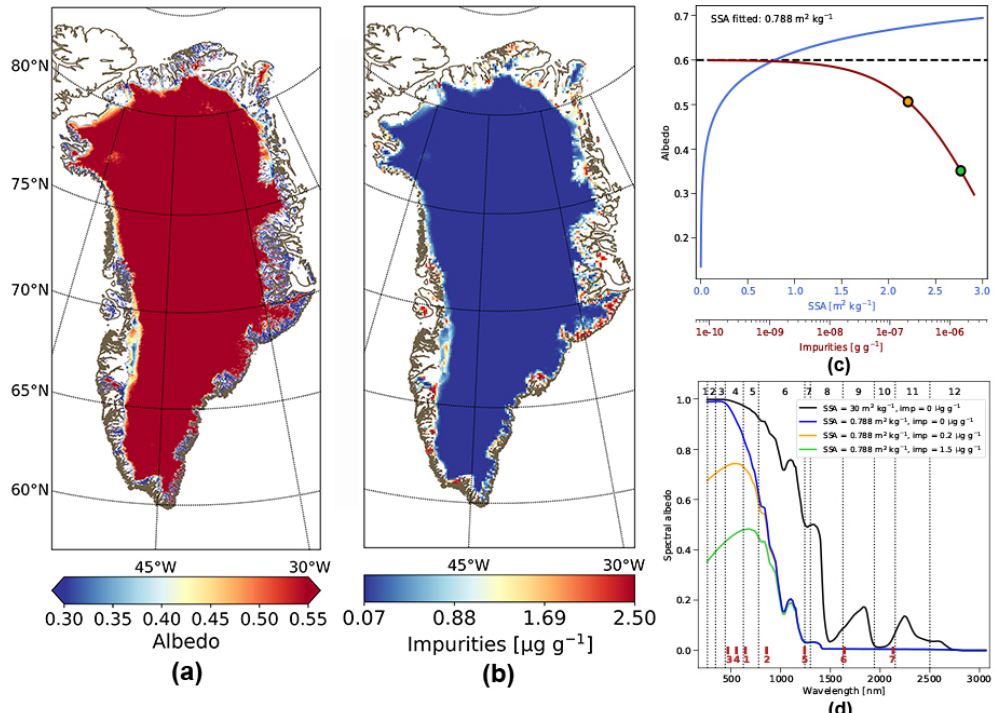
Figure 1. (a) Lowest 5% of the MODIS MCD43A3v5 1km 16d clear-sky diffuse albedo field for glaciated areas for the period 2000–2015. As this albedo field is used to determine a bare-ice albedo field, it is limited between 0.30 for dark ice in the ablation zone and 0.55 in the accumulation zone below perennial snow for consistency with RACMO2 (Noël et al., 2018). (b) Bare-ice impurity field that is implemented in RACMO2.3p3 for glaciated grid points. Here, all impurities are soot. (c) In blue, fitting the specific surface area (SSA) to clean blue ice albedo, which is assumed to be 0.6. The fitted SSA equals 0.788m 2 kg − 1 . In red, the soot concentration as a function of albedo required to successfully convert the MODIS albedo field into an impurity field. For both lines, clear-sky conditions are assumed for a SZA of 60 ◦ , and RACMO2 irradiance profiles are used to convert narrowband to broadband albedo. (d) Spectral albedo for clean fresh snow (in black), and for an ice profile with the fitted SSA of 0.788m 2 kg − 1 for various impurity concentrations. The first 12 spectral bands of RACMO2 are indicated by vertical dotted lines and black numbers. Red bars and numbers indicate the seven MODIS spectral bands. The albedo for the cases with soot concentrations of 0.2 and 1.5µgg − 1 are indicated with corresponding colored dots in (c)